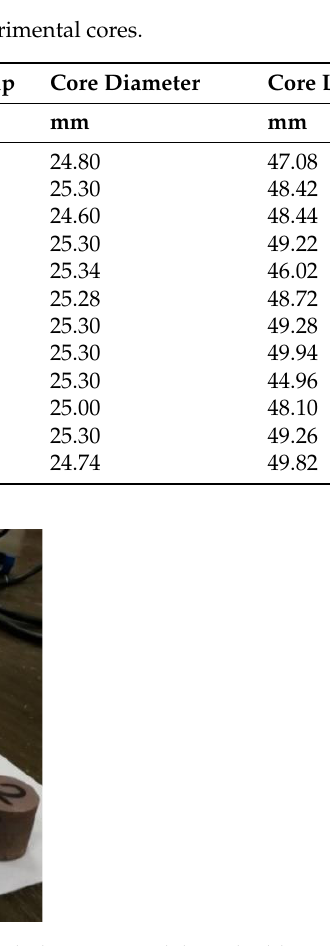
Figure 3. Photograph of the cut cylindrical plug core models with oblique fractures. Table 1. Physical parameters of the experimental cores.